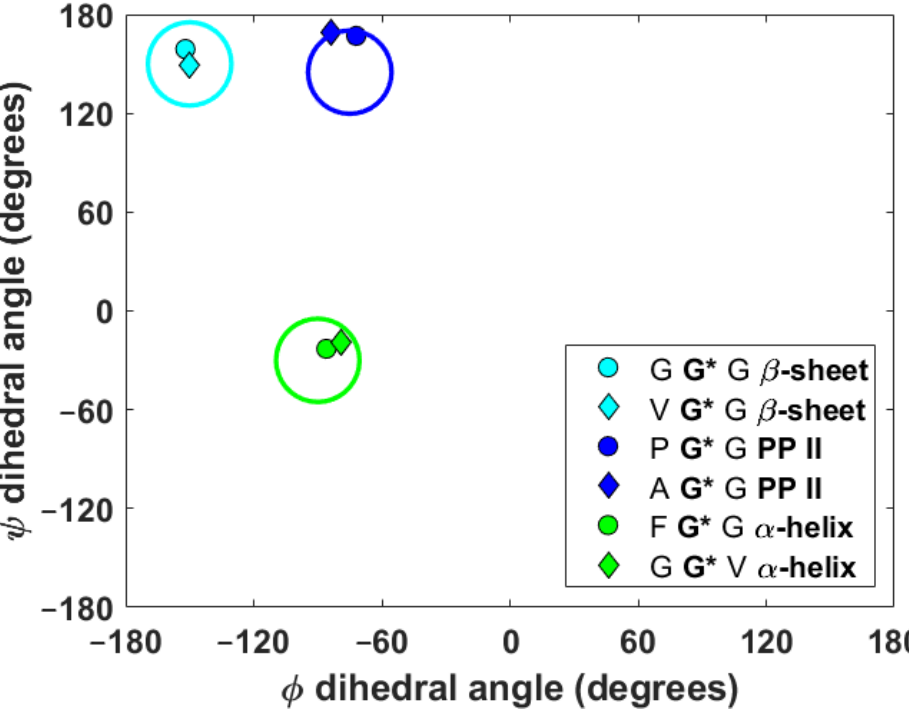
Figure 1. The Ramachandran plot for central glycyl residues in the set of tripeptides. Typical β -sheet, polyproline II (PP II) and α R -helical regions are schematically shown by large cyan, blue and green circles centered at [–150°; +150°], [–75°; +145°] and [90°; –30°], respectively.